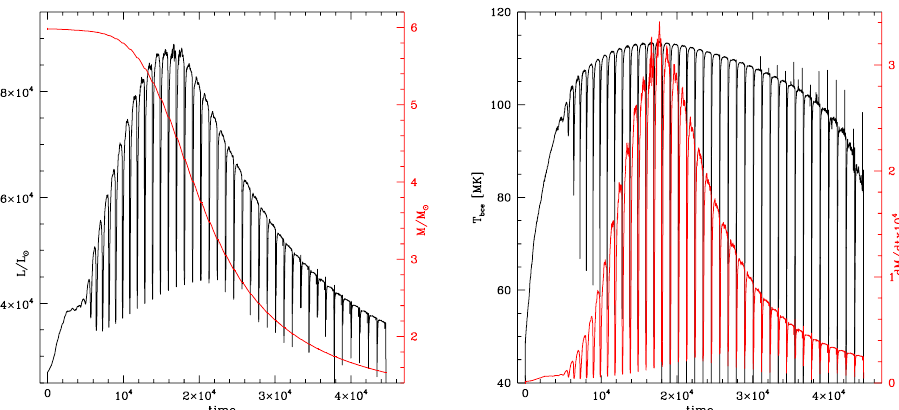
Figure 1. The variation with time (counted since the beginning of the AGB phase) of luminosity and current mass of the star ( left panel , black and red tracks, respectively), and of the temperature at the bottom of the envelope and the mass-loss rate ( right panel , black and red lines, respectively.)